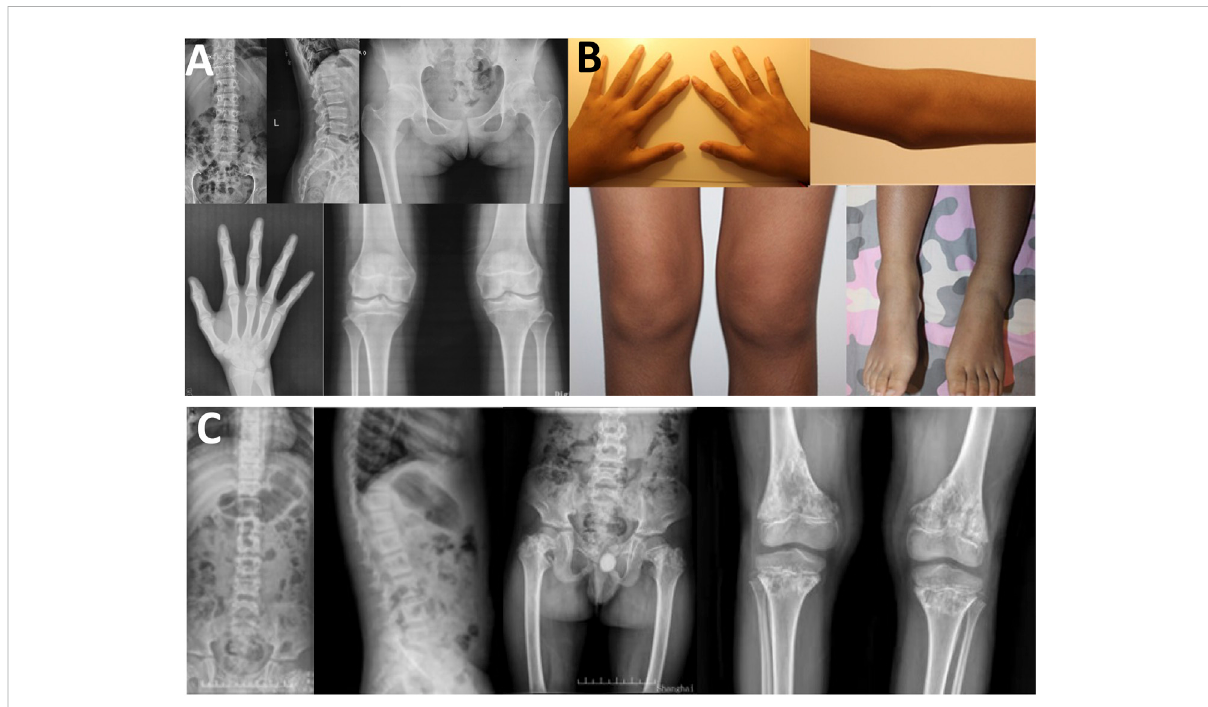
FIGURE 5 Photographs and radiographs of the families 5 and 6. (A,B) Radiographs of the spine, pelvis, hands, knees (A) and photographs (B) of proband 5 ( Ⅱ -1) in family 5. (A) Mild platyspondyly was revealed in the spine. The pelvis was normal. Expansion of metaphysis and stenosis of joint spaces were visible in hands. Widened epiphysis and joint cavity stenosis were displayed in the knees. (B) Bilateral elbow, knee, ankle, and multiple metacarpophalangeal and interphalangeal joints were enlarged. (C) Radiographs of the spine, pelvis, and knees of proband ( Ⅱ -1) in family 6. Irregular shape of the vertebral bodies was signi fi cant in the spine. Flattening of the acetabular roof, shortening of the femoral neck, mildly compressedfemoralhead,andthickeningofmetaphyseal textureweredisplayedinthepelvis.Widenedepiphysis andmetaphysis,irregularshapeof the epiphysis, and disorganization of the metaphysis were obvious in the